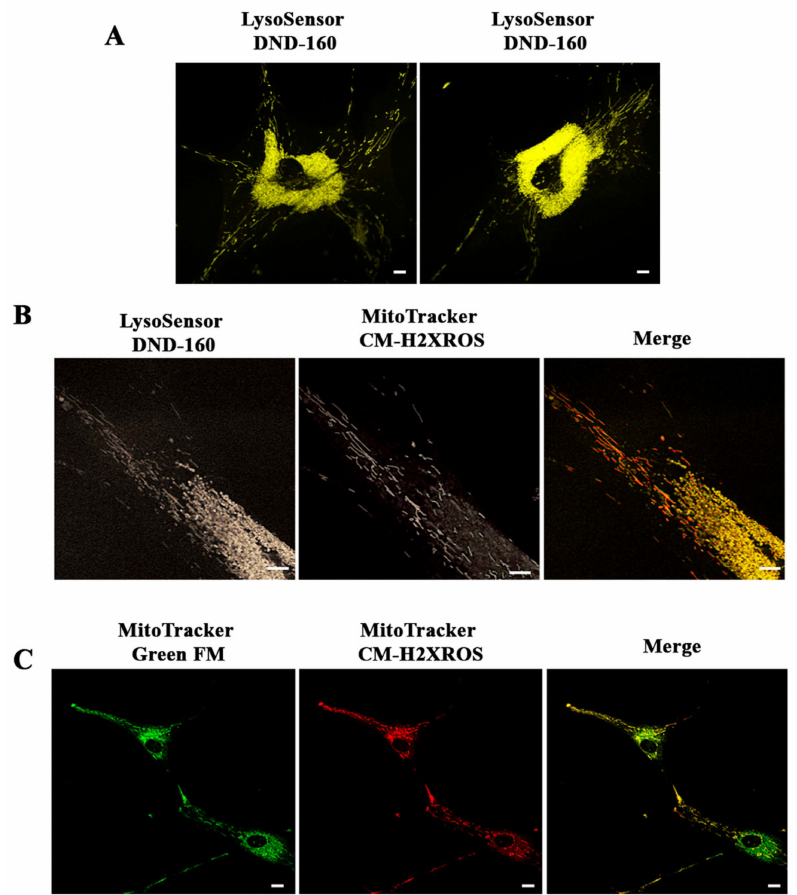
Figure 5. Altered intracellular distribution of mitochondria in PARK2 -PD cells. ( A , B ) Mitochondrial and lysosomal staining in PARK2 -PD cells was performed with LysoSensor DND-160 (yellow) and MitoTracker CM-H2XRos (red). In A two di ff erent PARK2 -PD cells labeled with LysoSensor DND-160 are shown. In B a peripheral detail of a cell labeled with LysoSensor DND160 and MitoTracker CM-H2XROS is shown ( C ) Staining with MitoTracker Green FM (green) and MitoTracker CM-H2XRos (red) in PARK2 -PD cells showing mitochondria in peripheral structures connecting cells suggesting mitochondrial transfer to neighboring cells. Scale bar: 10 µ